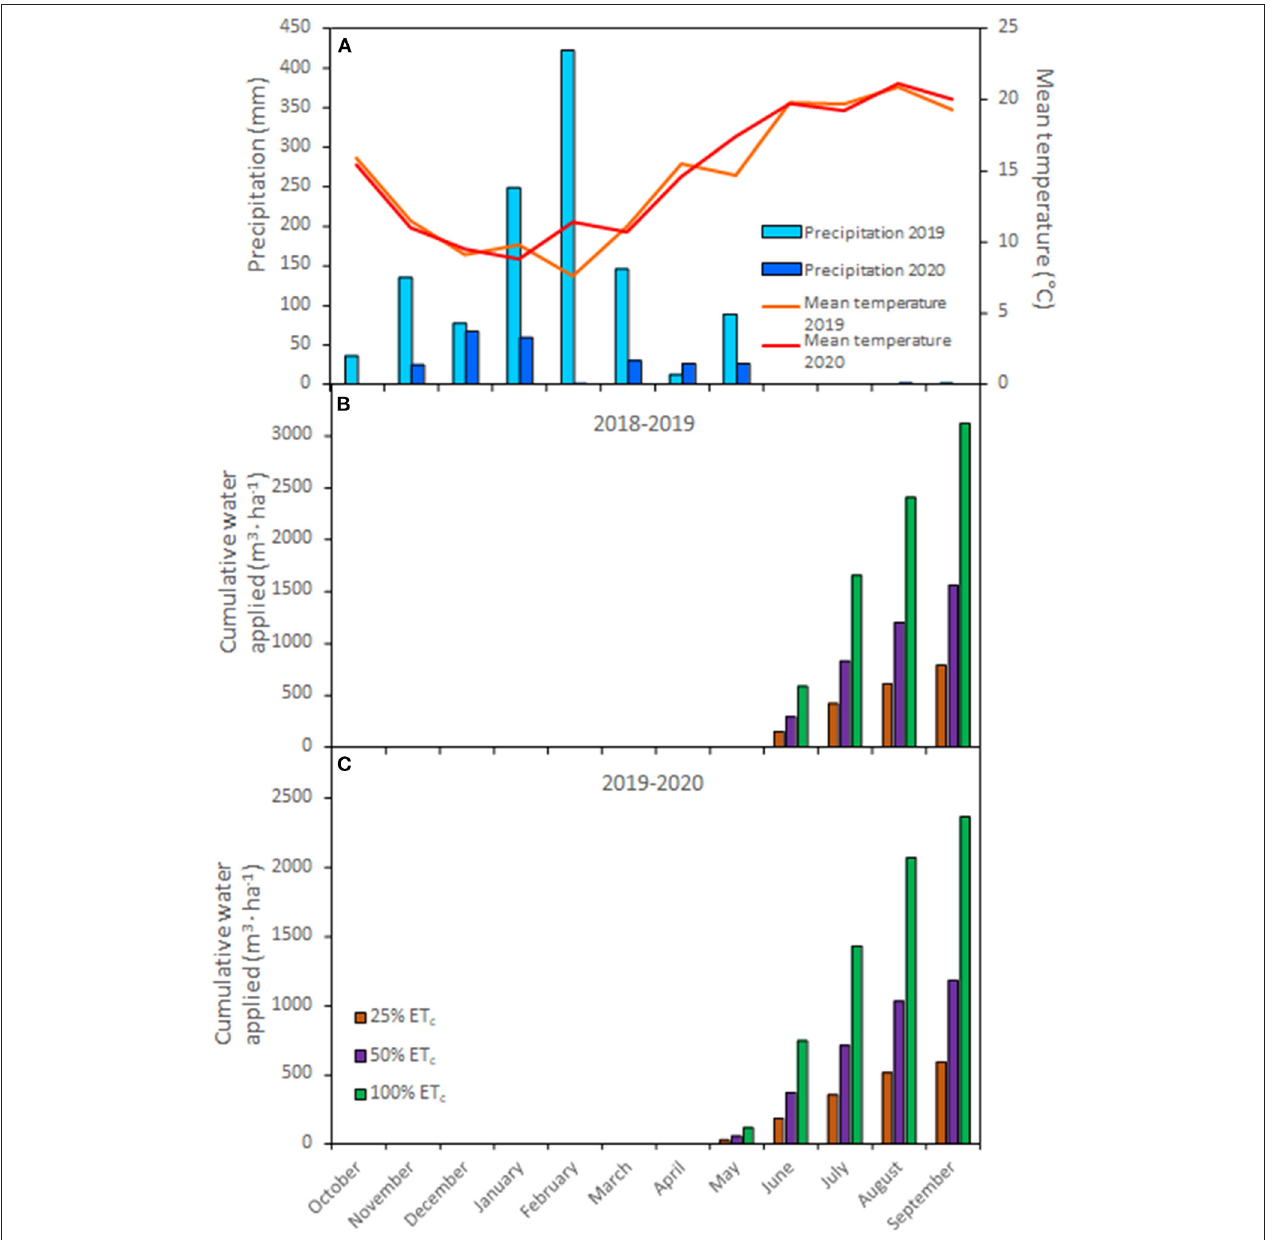
FIGURE 1 | Mean air temperature ( ◦ C) and precipitation (mm) during the 2018–2019 and 2019–2020 growing seasons (A) Weather data were obtained from the CIMIS weather station # 77 (Oakville, CA) located at the research site. Cumulative water applied (m 3 · ha − 1 ) to Cabernet Sauvignon grapevines (clone FPS08) according to the different replacements of crop evapotranspiration (25, 50, and 100% ET c ) during the 2018–2019 (B) and 2019–2020 (C) growing seasons in Oakville, CA.